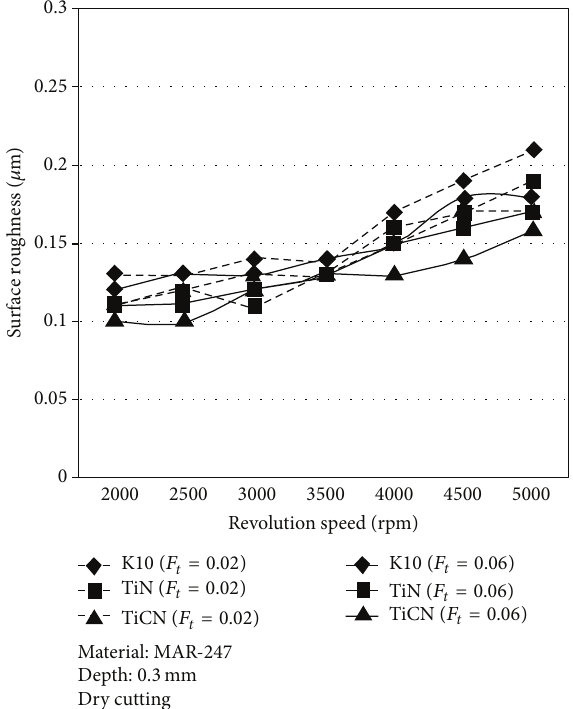
Figure14:Relationshipsbetweenrevolutionspeedofmainshaftand surface